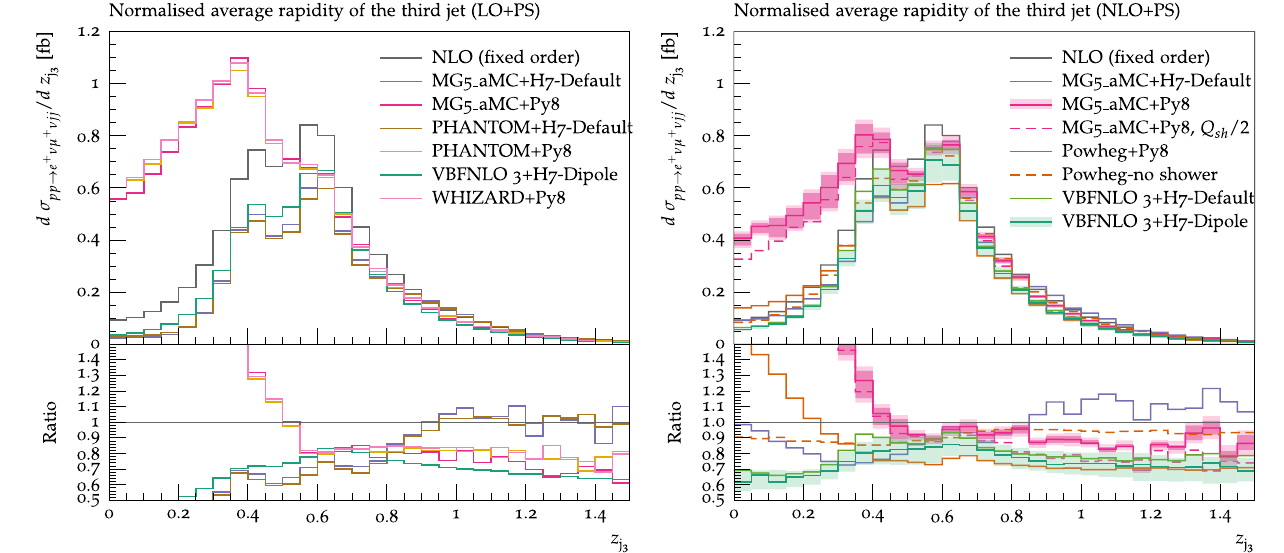
Fig. 19 DifferentialdistributionintheZeppenfeldvariableofthethird- hardest jet from predictions matched to parton showers, at LO (left) or NLO (right) accuracy (upper plot), compared with the fixed-NLO result computed with VBFNLO (lower plot). At NLO+PS accuracy, for VBFNLO + Herwig7- Dipole , the three-point scale uncertainties are